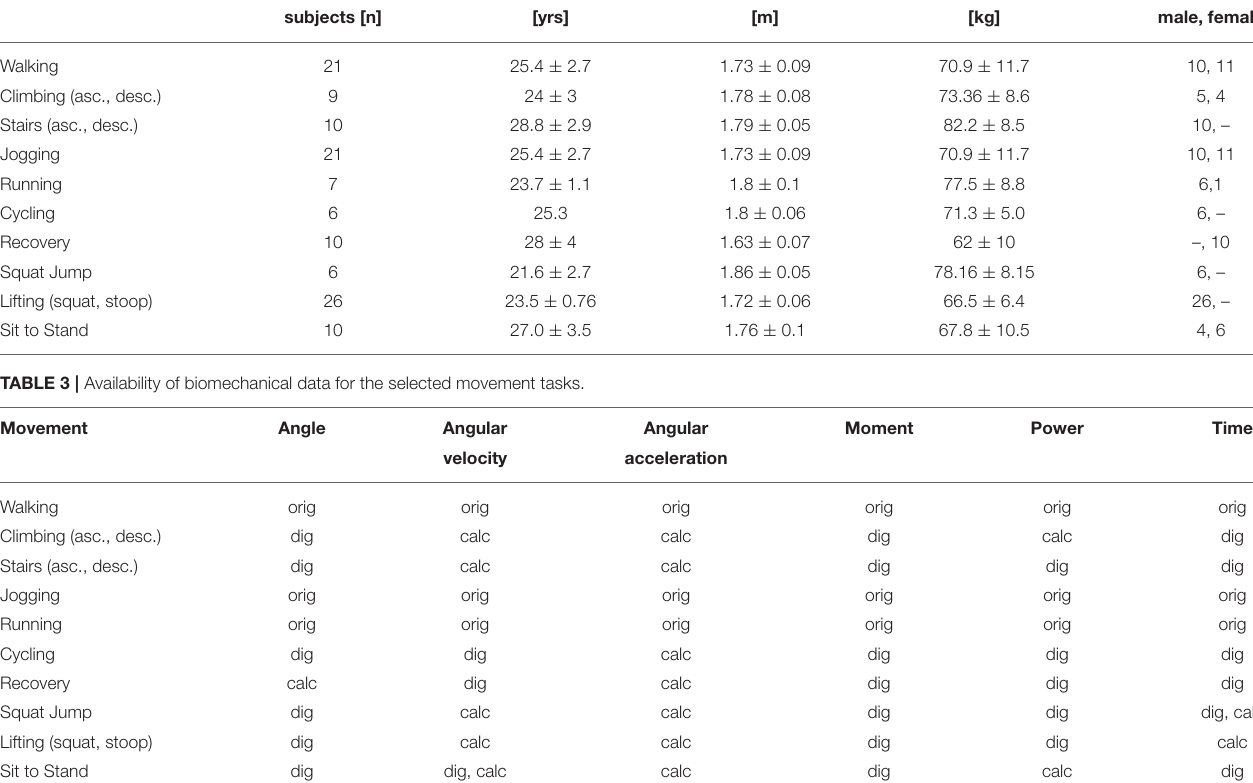
Walking Climbing (asc., desc.)